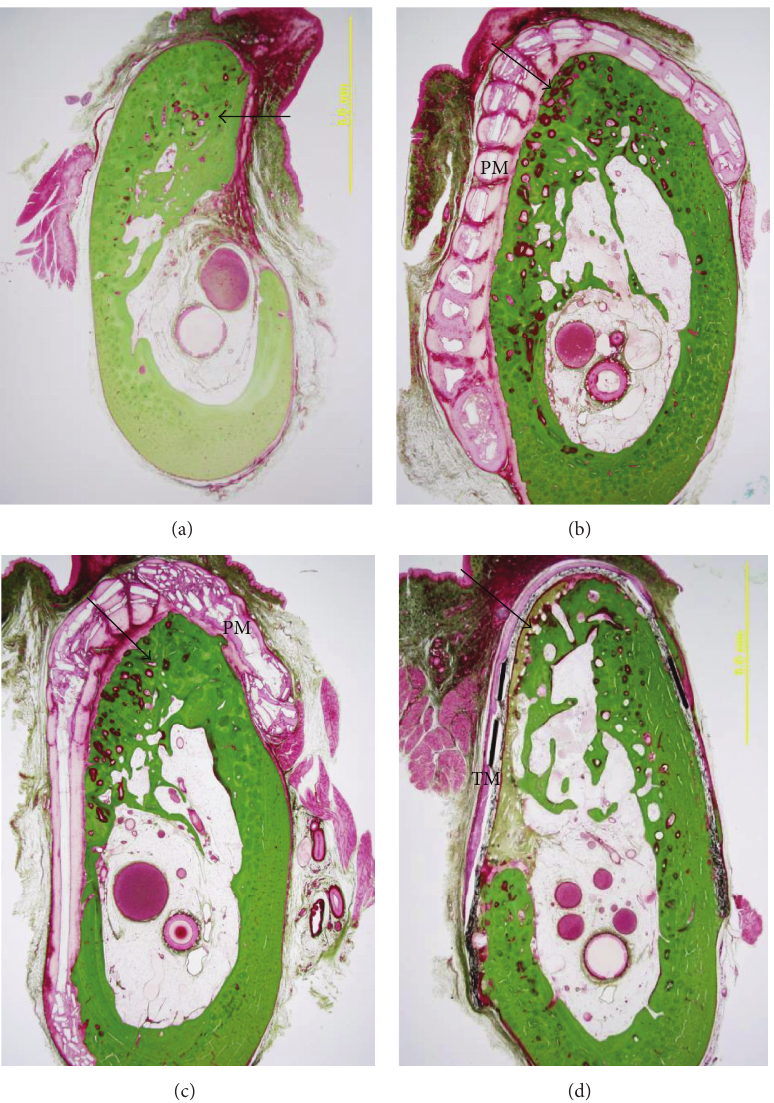
Figure 2: Histological microphotographs of coronal sections at 6 months postoperatively [33]. The Villanueva-Goldner staining: (a) control (virgin) group, (b) GBR using PLGC membrane, (c) GBR using PLGC+bone chips group, and (d) GBR using TR-PTFE membrane. PM: PLGC macroporous membrane. TM: TR-PTFE membrane, and arrow: regenerated